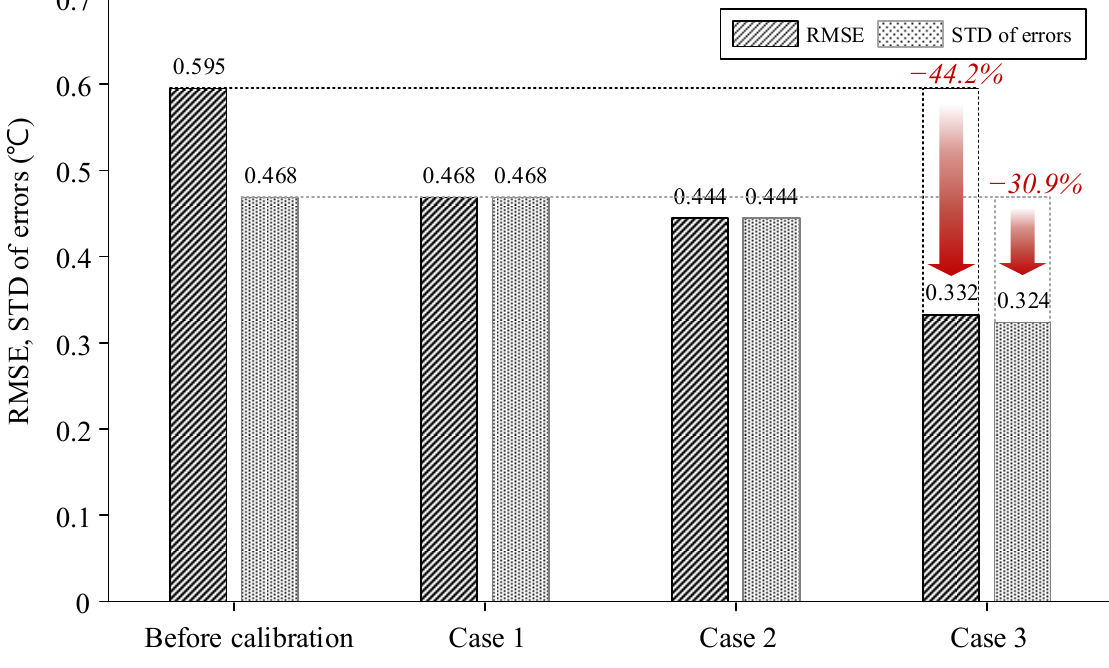
Figure 5. Comparison of the RMSEs of the three calibration cases for the calibration period.